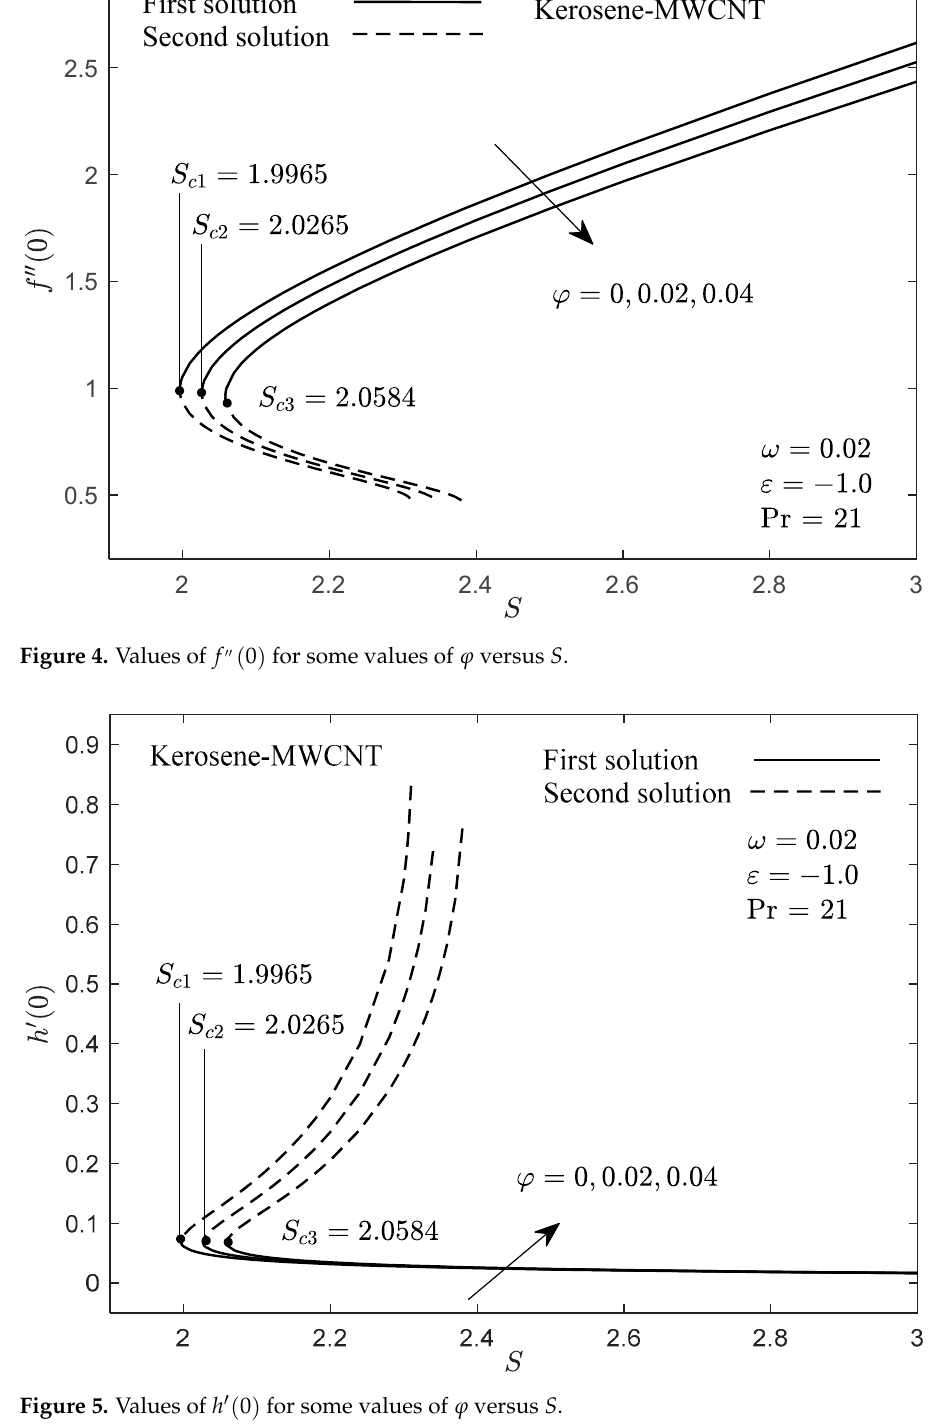
Figure 5. Values of ℎ′(0) for some values of 𝜑 versus 𝑆 .